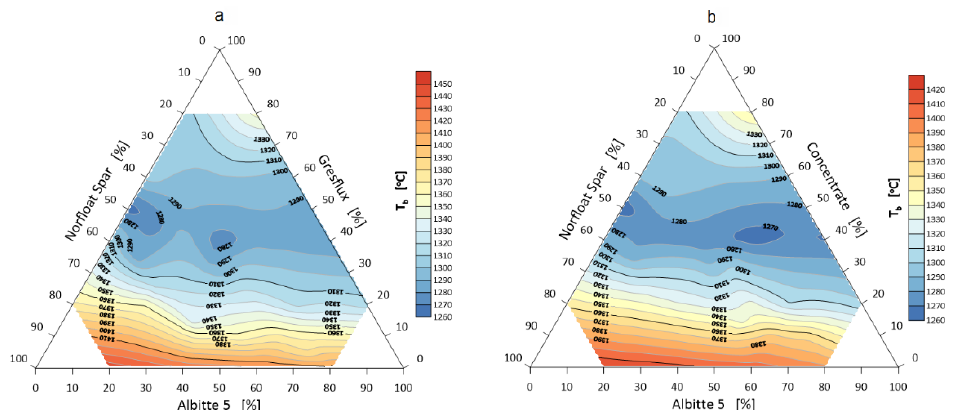
Figure 5. Melting temperature (hemisphere) T b of the flux system Greflux–Albitte 5–Norfloat Spar ( a ), and Concentrate–Albitte 5–Norfloat Spar ( b ).